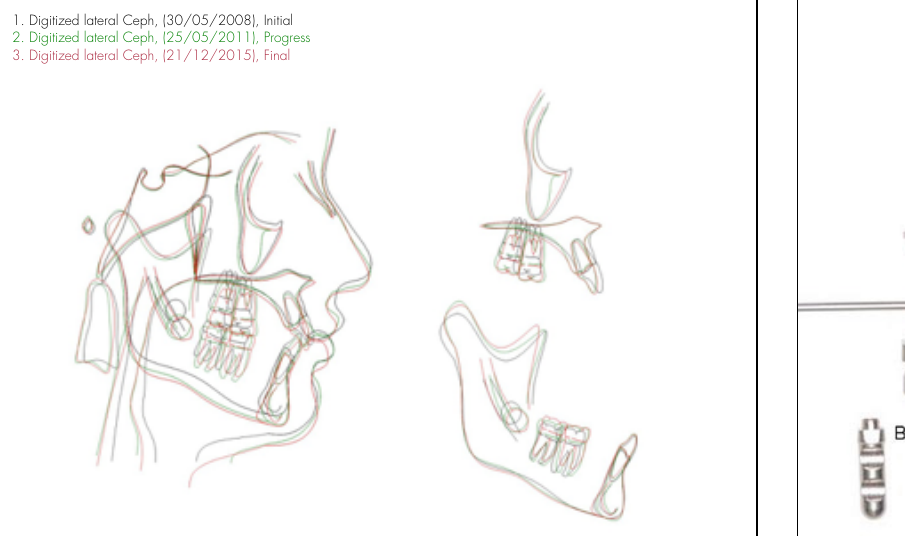
Figure 20. Superimposition of the pre- and post-treatment lateral cephalograms. Figure 21. The Benefit Mini-Implant system and its